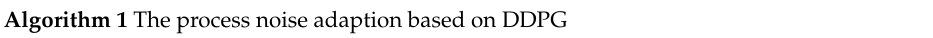
Algorithm 1 The process noise adaption based on